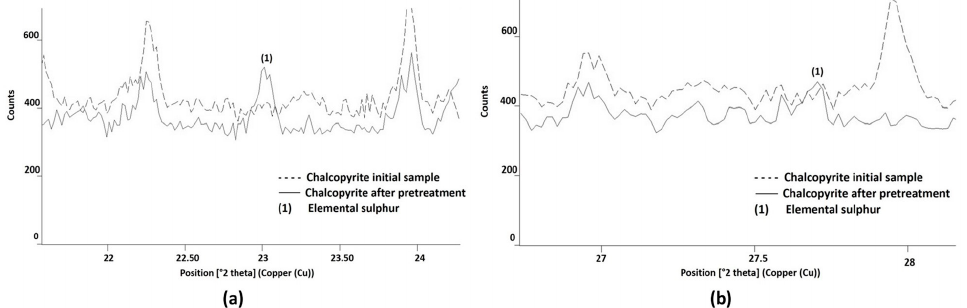
Figure 10. Elemental sulphur identified by X-ray diffraction, a product of the pretreatment of chalcopyrite mineral with 15 kg/t of H 2 SO 4 , 25 kg/t of NaCl, and 15 days of curing at room temperature. In ( a , b ) the new presence of elemental sulphur was identified as (1), compared with the initial diffractogram of the sample.